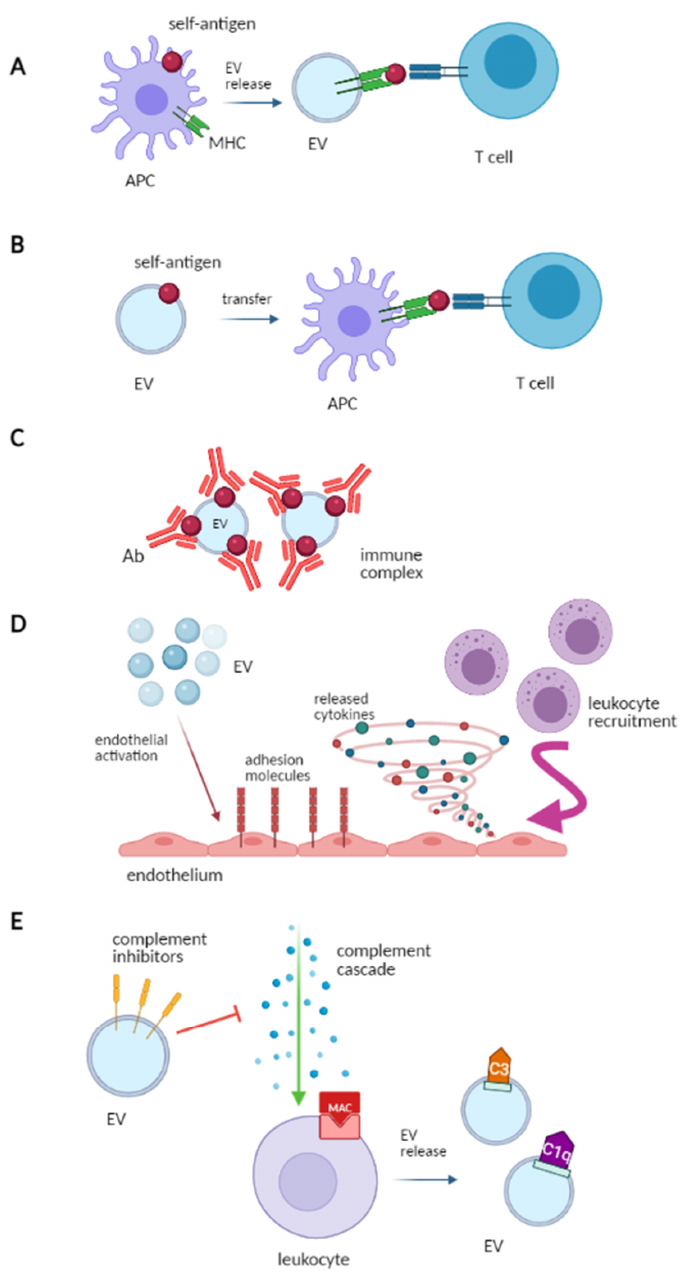
Figure 2. EV and immune system modulation: ( A ) Self-antigen presentation: antigen-presenting cells (APC) can vehicle self-antigens and release extracellular vesicles (EV) which present autoantigens to autoreactive T cells. ( B ) Self-antigen transfer: EV carrying self-antigens transfer them to APC which present them to T cells, triggering an autoimmune response. ( C ) Immune complex formation (IC): EV can participate in IC formation by carrying self-antigens that are bound by circulating autoantibodies. ( D ) Activation of innate immunity: EV can stimulate cytokine release and the upreg- ulation of adhesion molecules on endothelial cells, which favor circulating immune cell recruitment. ( E ) Interaction with the complement system: the complement cascade can be activated on circulating leukocytes which can then release EV exposing complement molecules (e.g., C3, C1q). EV can also convey complement inhibitors and modulate the complement system. This Figure has been created using Servier Medical Art templates, which are licensed under a Creative Commons Attribution 3.0 Unported License; https://smart.servier.com (accessed on 28 March